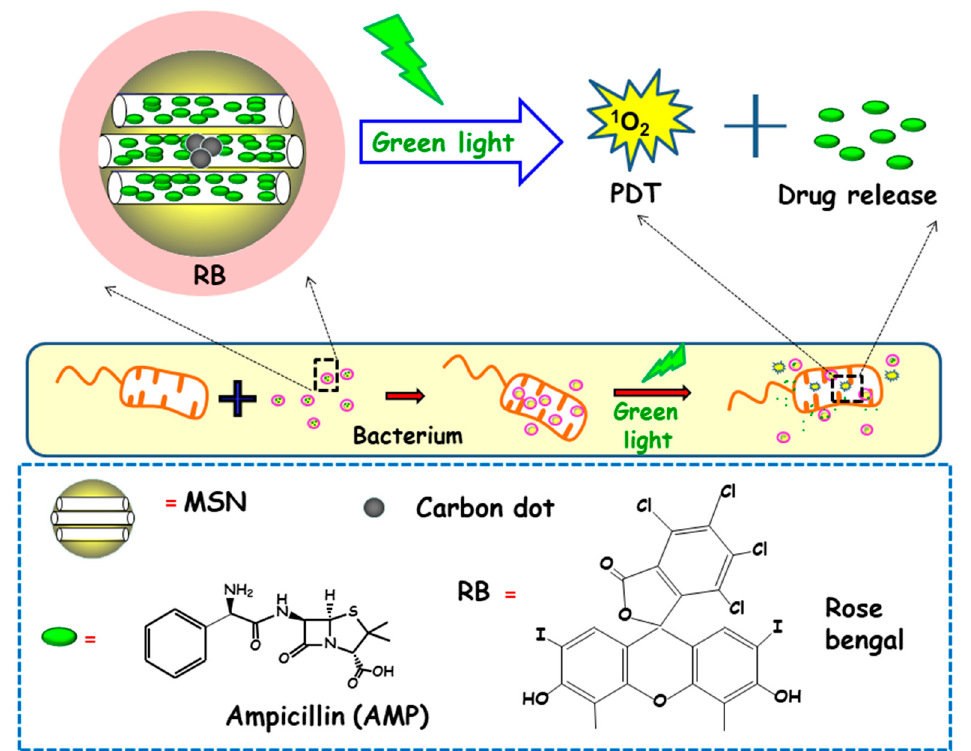
Figure 10. Schematic depiction of the mechanism of action of antimicrobial light-responsive antimicrobial nanosystems consisting MSNs containing carbon dots (C-dots), rose bengal (RB) and ampicillin (AMP). Adapted from ref. [98]. Upon green light irradiation of nanosystems, the RB photosensitizer triggers the generation of singlet oxygen species ( 1 O 2 ), which produces pore uncapping and AMP release. Synergistic combination of photodynamic therapy (PDT) and antimicrobial release lead to enhanced antimicrobial effect.